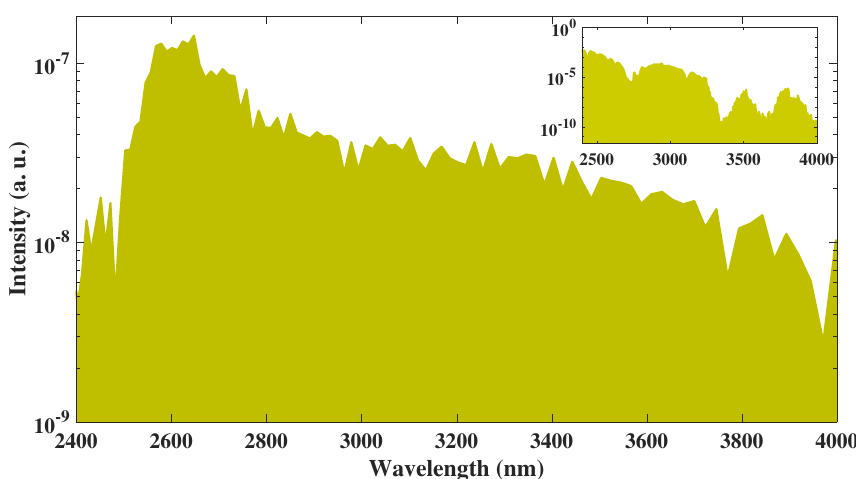
Figure 7. Supercontinuum spectrum using the pump pulses after 30 round trips. Inset: MIR portion of the SC spectrum generated by pump pulses after 45 round trips.